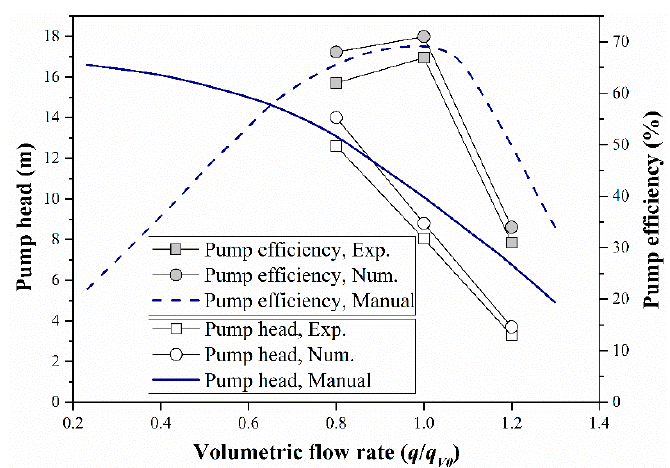
Figure 6. Comparison of numerical data and test data with the case of D / L = 2.